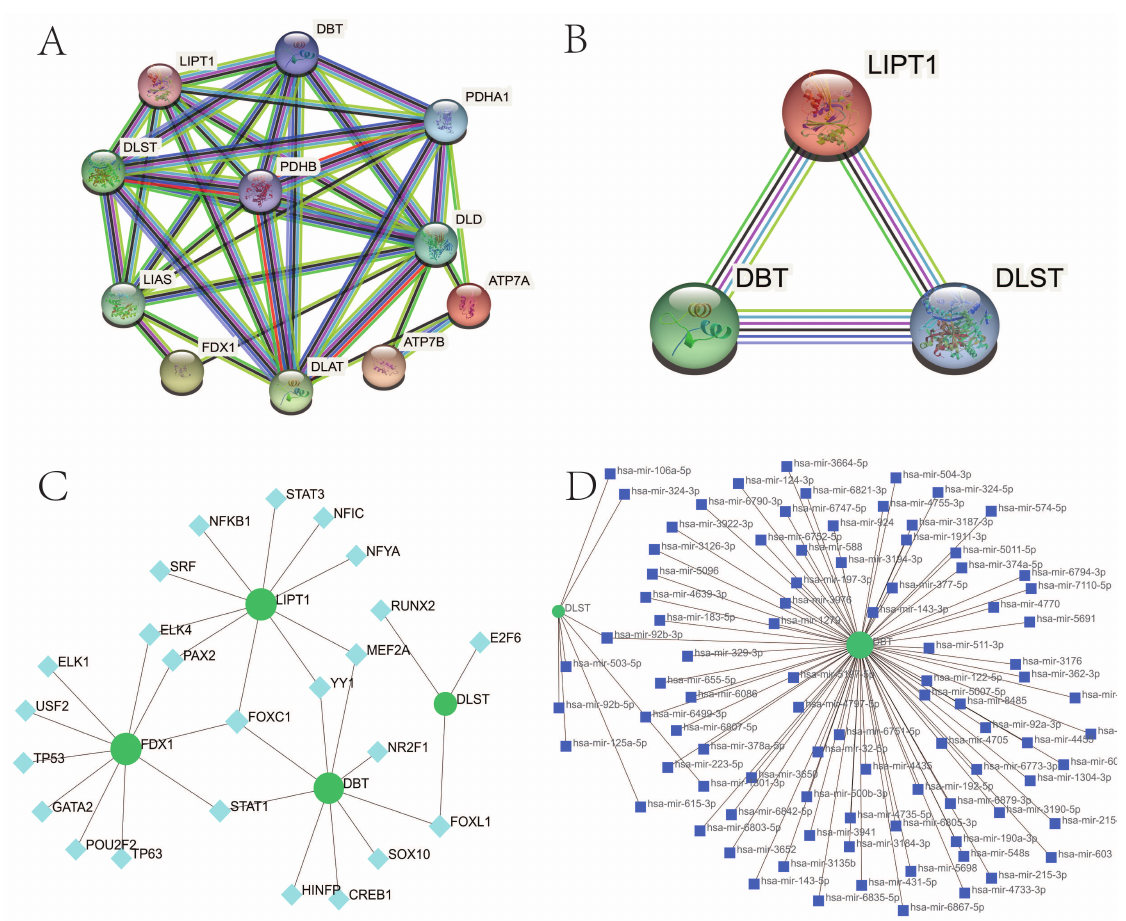
Figure 5. PPI network of CRGs in OA. ( A ) The PPI network of 11 CRGs had 11 nodes and 35 edges. ( B ) The PPI network of four hub CRGs. CRGs, cuproptosis-related genes; PPI, protein–protein interaction; OA, osteoarthritis. ( C ) The cohesive regulatory interaction network of four hub gene– TF. Herein, the square nodes were TFs, and gene symbols interacted with TFs as circle nodes. TF, Transcription factors. ( D ) The interconnected regulatory interaction network of four hub gene– miRNA. Herein, the square node indicated miRNAs and gene symbols interacted with miRNAs as a circle shape. miRNAs,